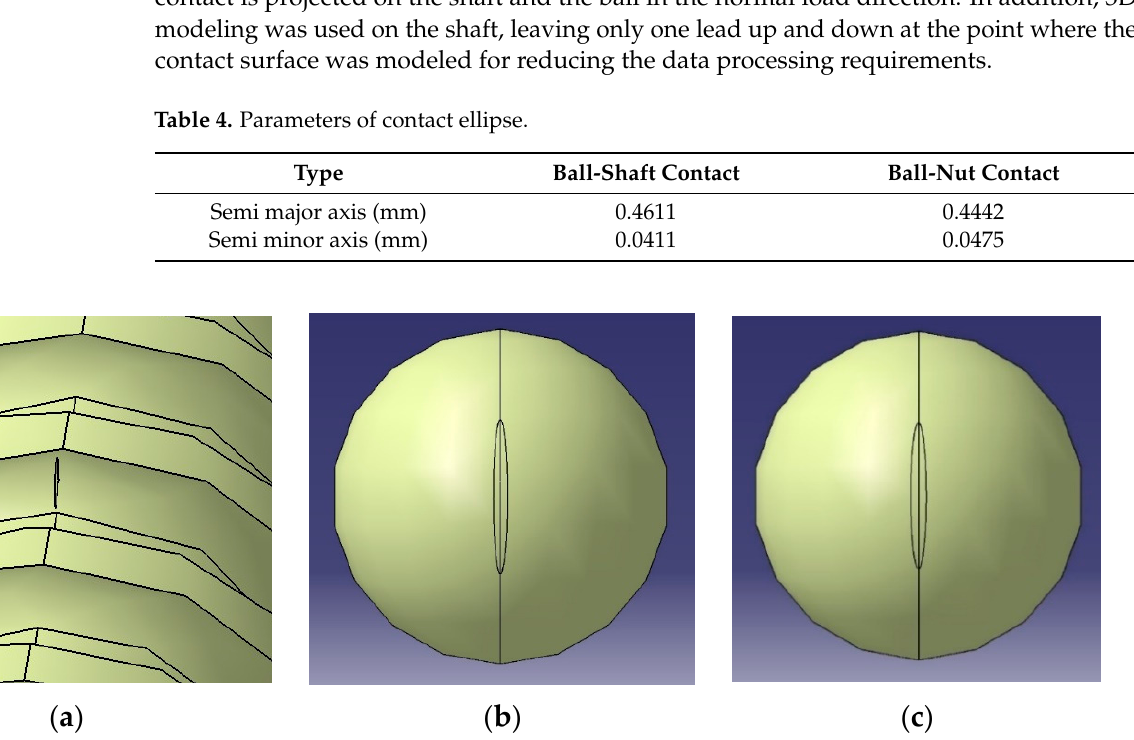
Figure 5. Contact ellipse configuration: ( a ) Shaft; ( b ) Ball (ball shaft contact); and ( c ) Ball (ball nut contact).